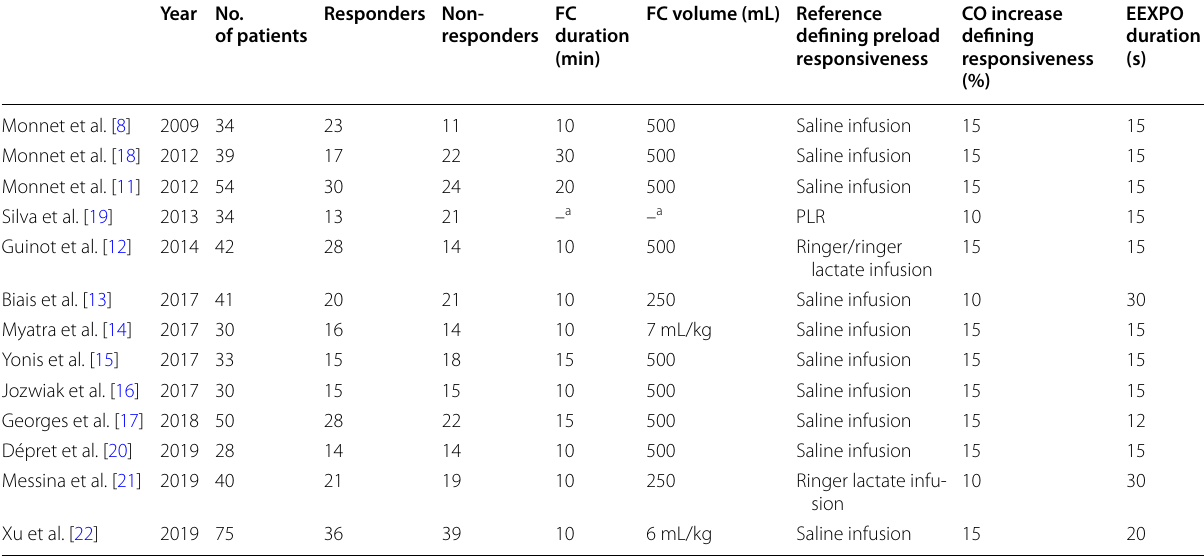
Table 2 Modalities of the end-expiratory occlusion test and of fluid